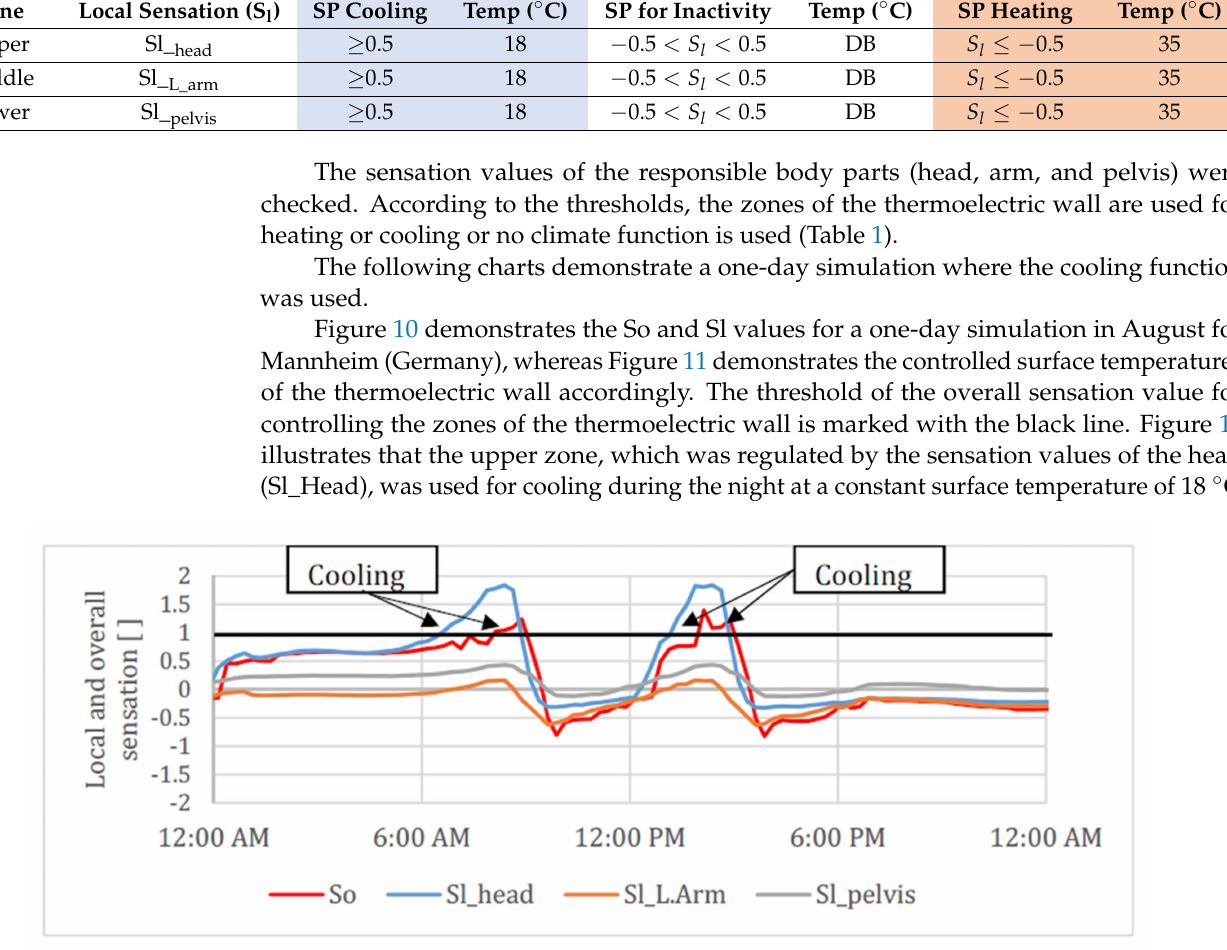
Figure 10. Local and overall sensation values to control the surface temperatures of the thermoelectric partition—one-day simulation in August; using the heating function was not allowed.